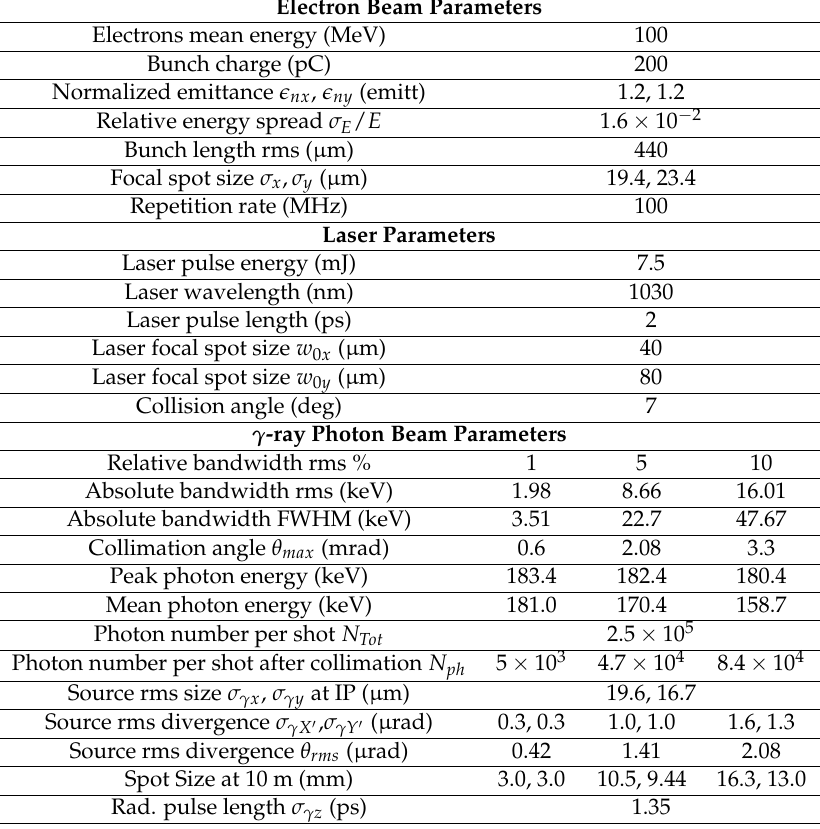
Table 6. Parameters of start to end simulations for the high energy